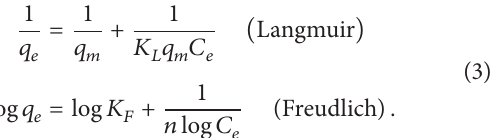
Figure 3: Comparison between the efficiency of AC1, AC2, and AC3 on the removal of BBG.